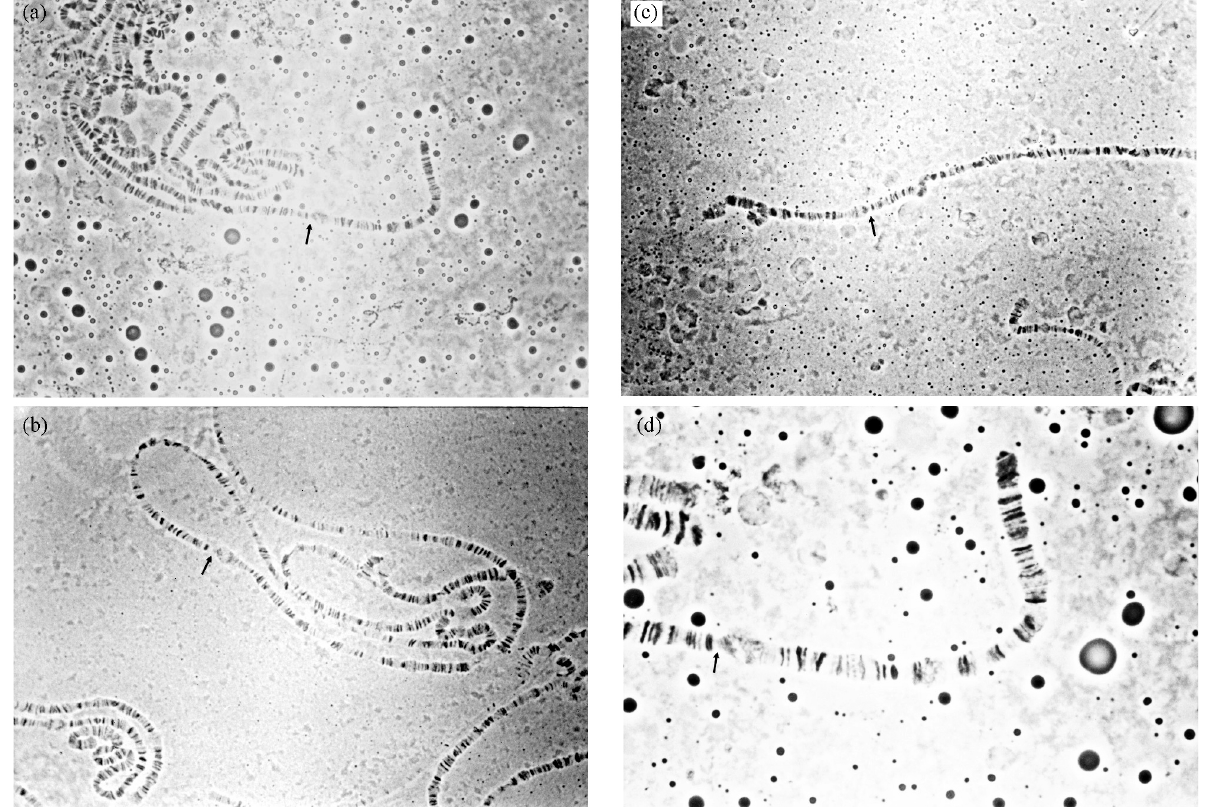
Figure 4 - Different pictures where the constriction located near the O 5 inversion proximal breakage point (indicated by an arrow) is presented. (a, b and c) 400X. (d)